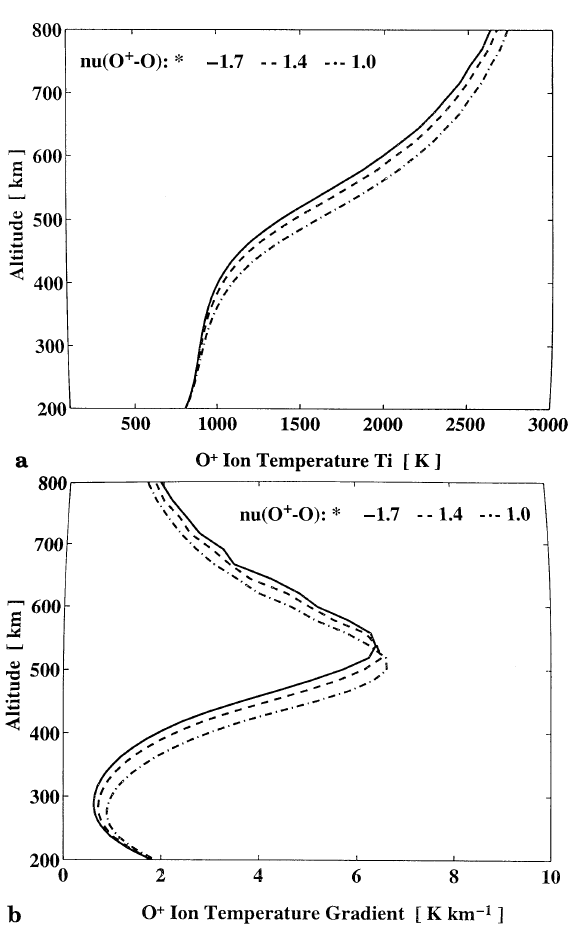
Fig. 8a,b . Effect, in the altitude range of interest, of the Burnside correction factor to O (cid:96) -O collision cross-section on the profiles of a O (cid:96) ion temperature and b O (cid:96) ion temperature gradient. The full line corresponds to the standard admitted value of 1.7 (Salah, 1993), the dashed line to the value of 1.4 as suggested by Davis et al . (1995) and the dot - dashed line to the collision cross-section initially sugges-